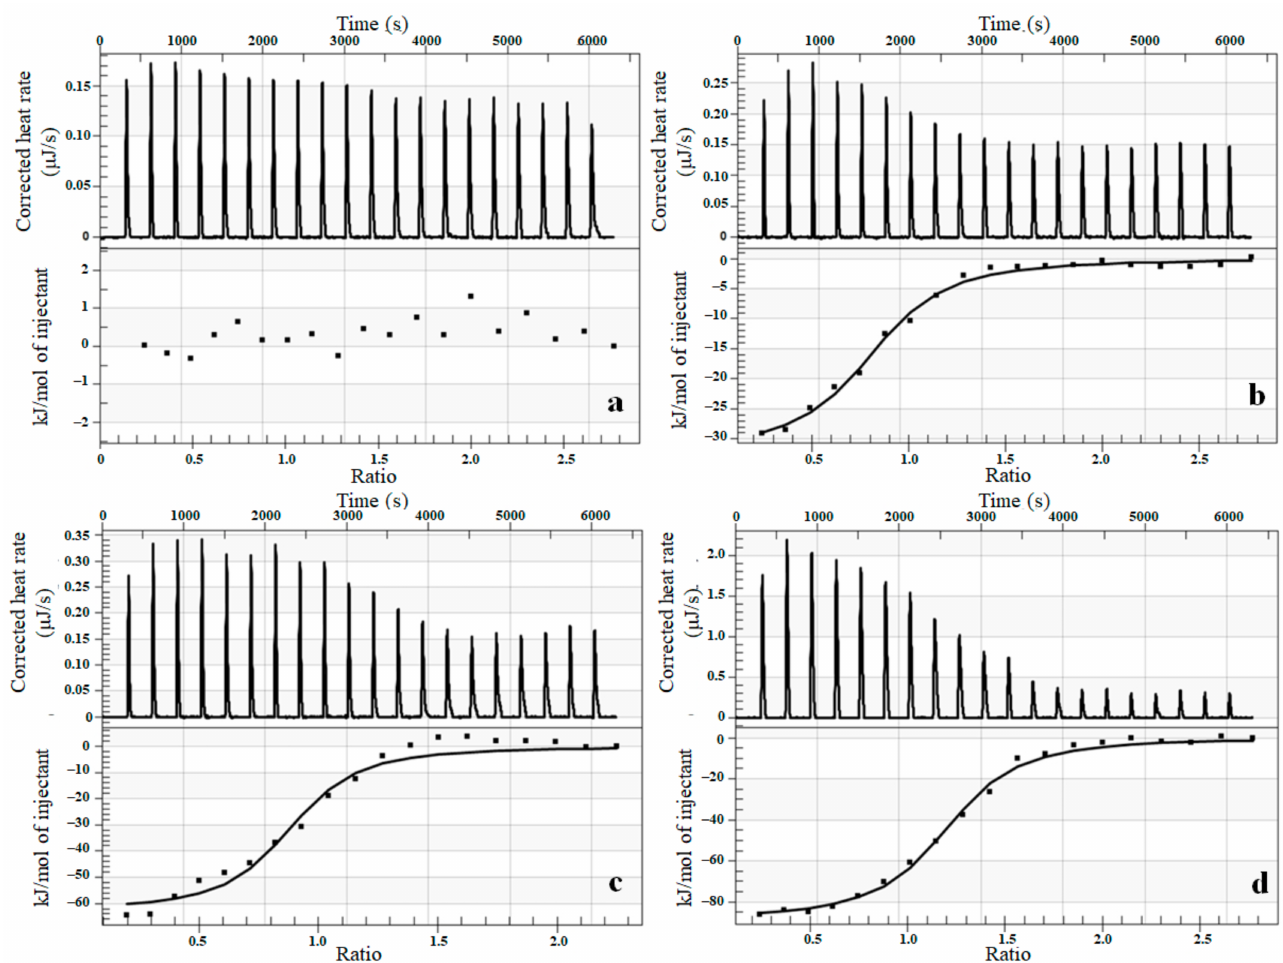
Figure 6. Representative ITC data for complex 1 binding to bactosomes CYP1A2 ( a ), bactosomes CYP2A6 ( b ), bactosomes CYP3A4 ( c ), and recombinant human CYP3A4 ( d ). (Top) Raw data plot of heat flow against time for the titration of CYP with complex 1 . (Bottom) Plot of molar enthalpy change against the complex 1 /cytochrome P450 molar